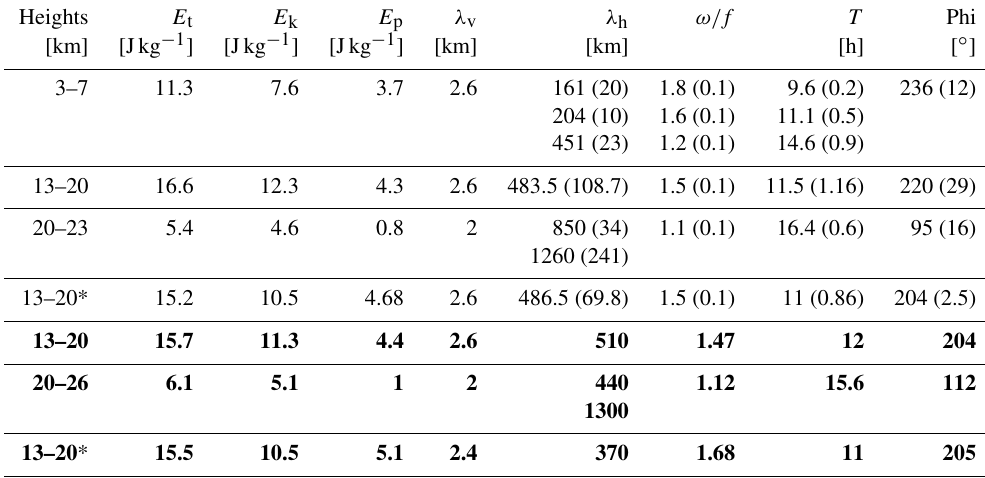
Table 1. Characteristics of dominant GWs on 27 July at 23:03UTC above Ile du Levant using a hodograph analysis and combined conven- tional methods (bold font) on observed and simulated (marked by *) profiles. Values are derived from peaks of wave parameter distributions. Height: altitude range, E t : total energy density, E k : kinetic energy, E p : potential energy, Phi: direction of horizontal wave propagation (clock- wise from north), λ v , λ h : vertical and horizontal wavelengths, ω/f : intrinsic frequency/inertial frequency, T : period. Parentheses denote standard deviation. Units are in brackets.